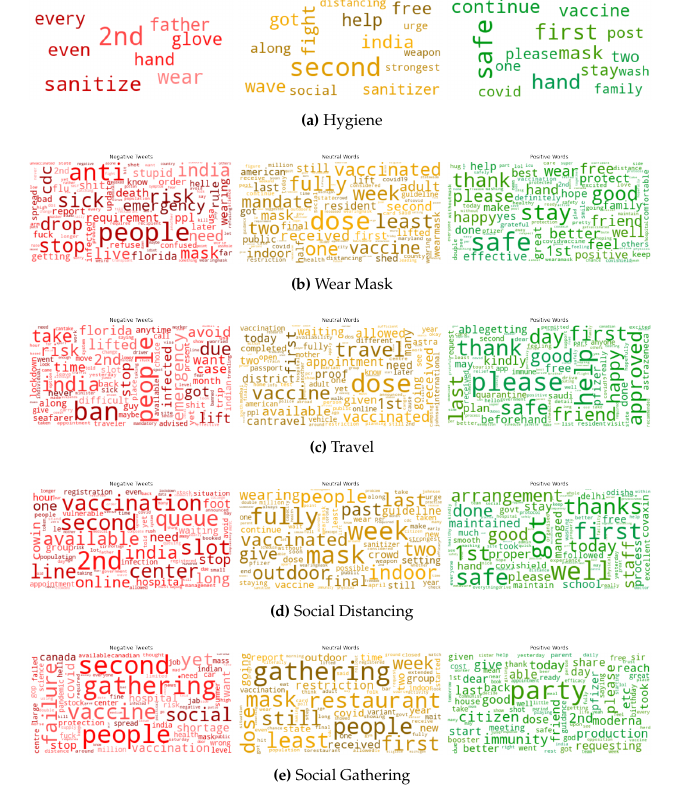
Figure 10. Combined Top Frequency Words on Twitter Dataset 2 on Healthy Lifestyle